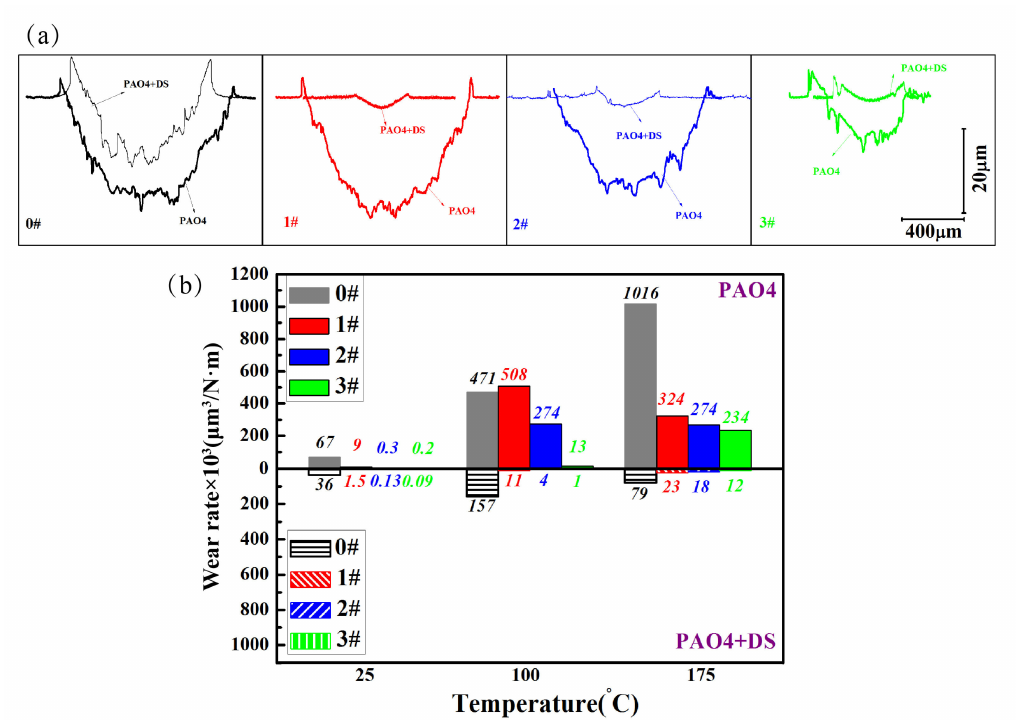
Figure 7. Cross-section profiles of worn plates at ( a ) T = 100 ◦ C; ( b ) wear rates of different samples in different